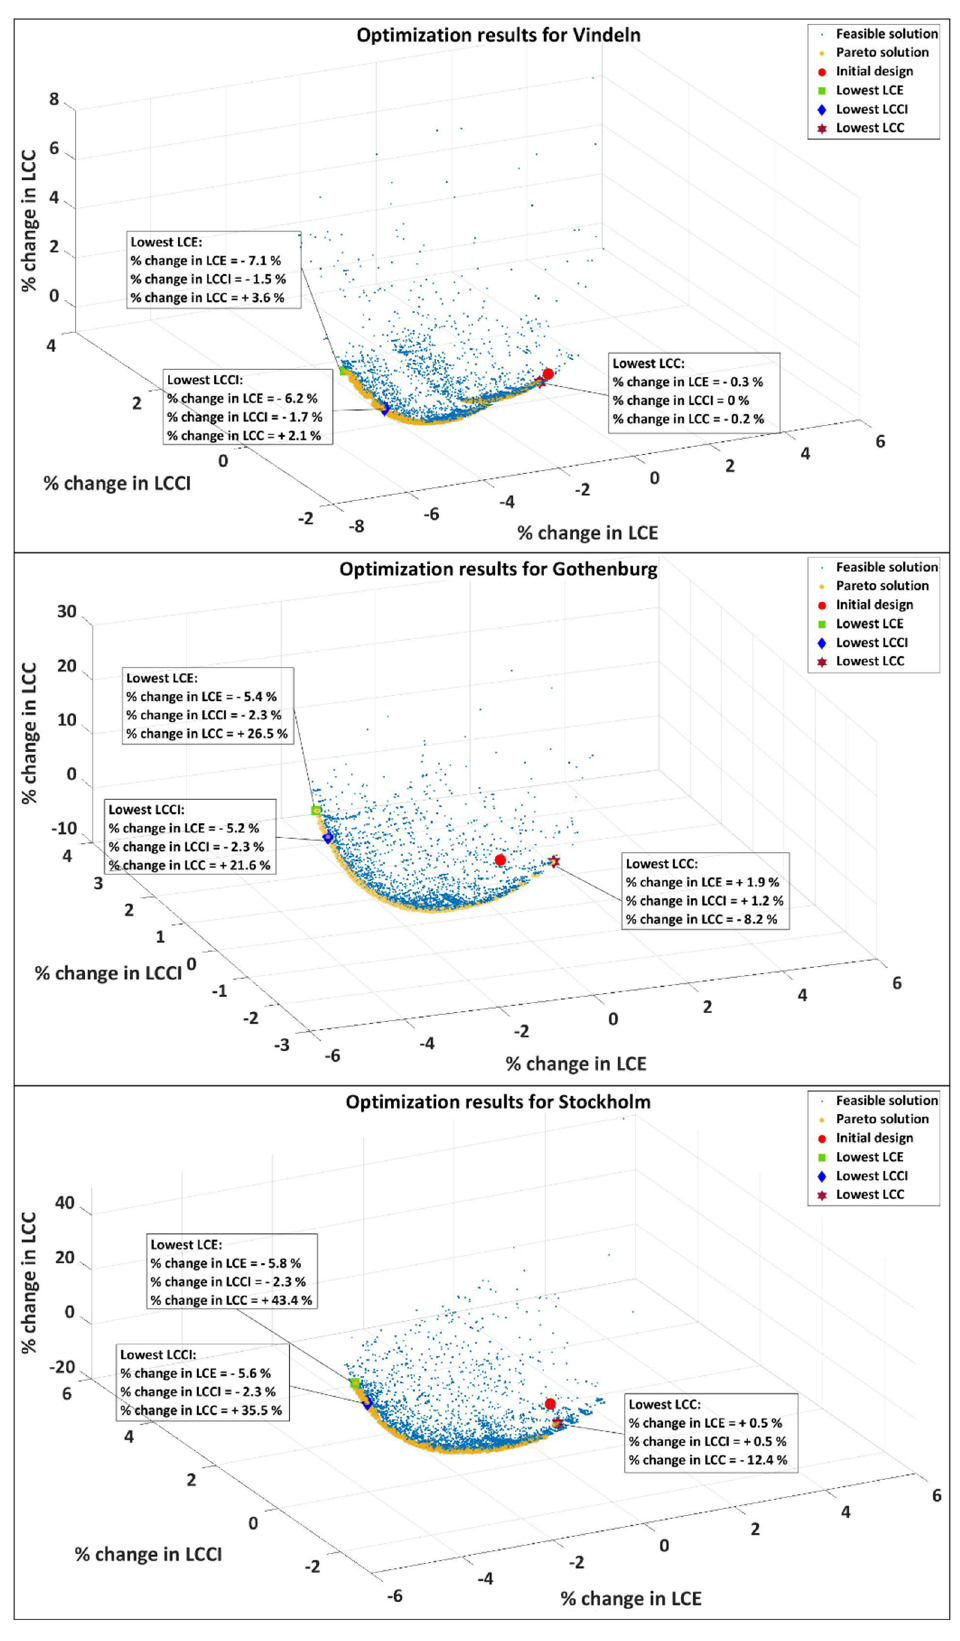
Figure 6. The percentage change in energy, carbon impact, and cost values of the feasible solutions relative to the initial design of the building concept for different locations. A colour print is recommended.